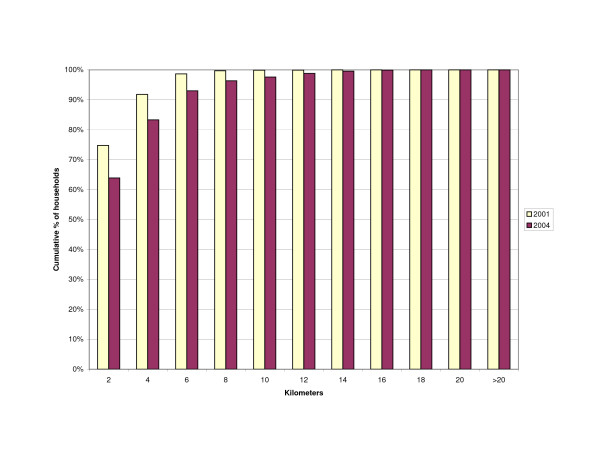
Cumulative percentage of households within given distance to nearest shop stocking antimalarials (general shops and drug stores).